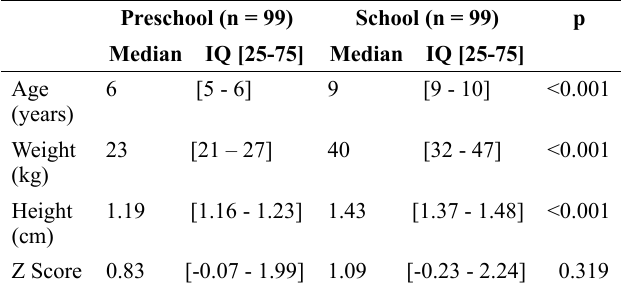
Table 1. Sample characteristics on assessment (preschool) and reassessment (school).